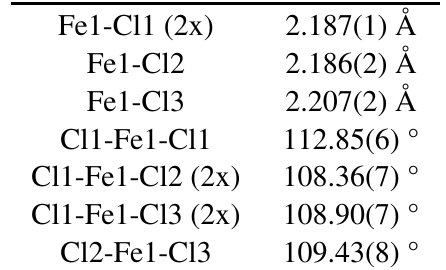
Table 1. Crystallographic information about the structure solution of (Hbet)